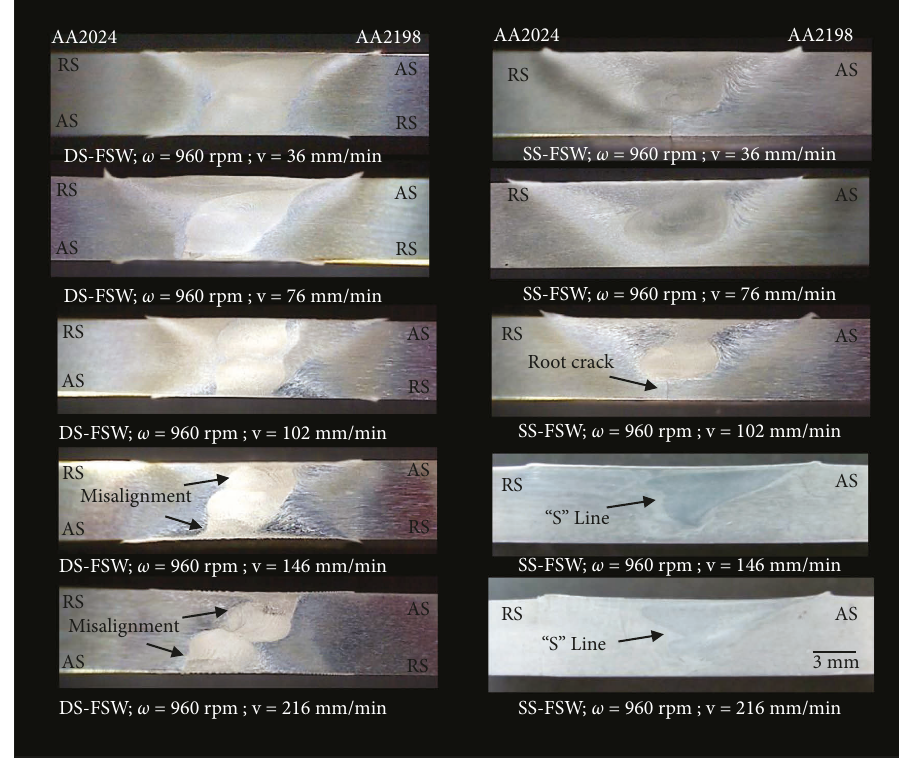
Figure 3: Macrostructure of reversed DS-FSW and SS-FSW joints AA2198-T8 to AA2024-T3 at various welding